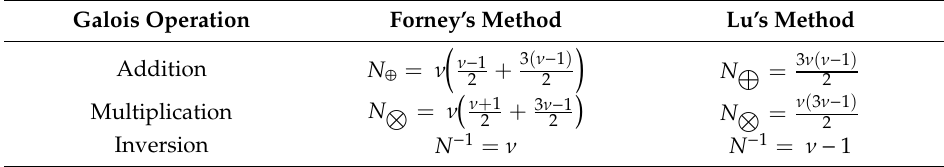
Table 1. Number of Galois field operations required by Forney’s and Lu’s methods.